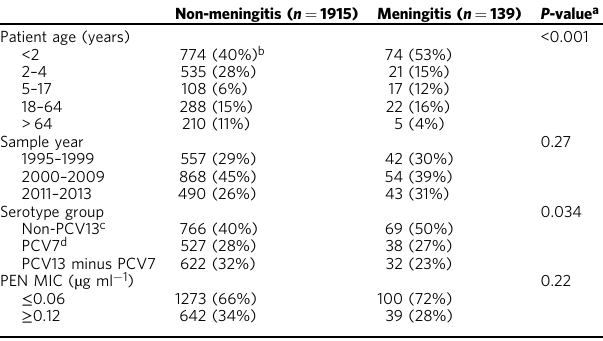
Table 1 Characteristics of invasive pneumococcal isolates in the exploratory